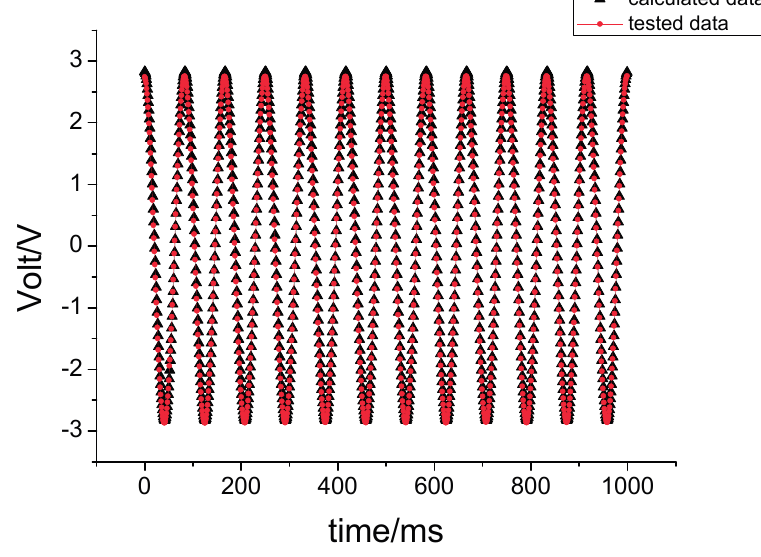
Figure 9. The experimental results when 180°/s is entered on the pitching axis.